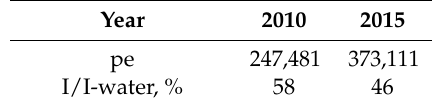
Table 11. Calculated values of I/I-water for some big Swedish plants for 2010 and